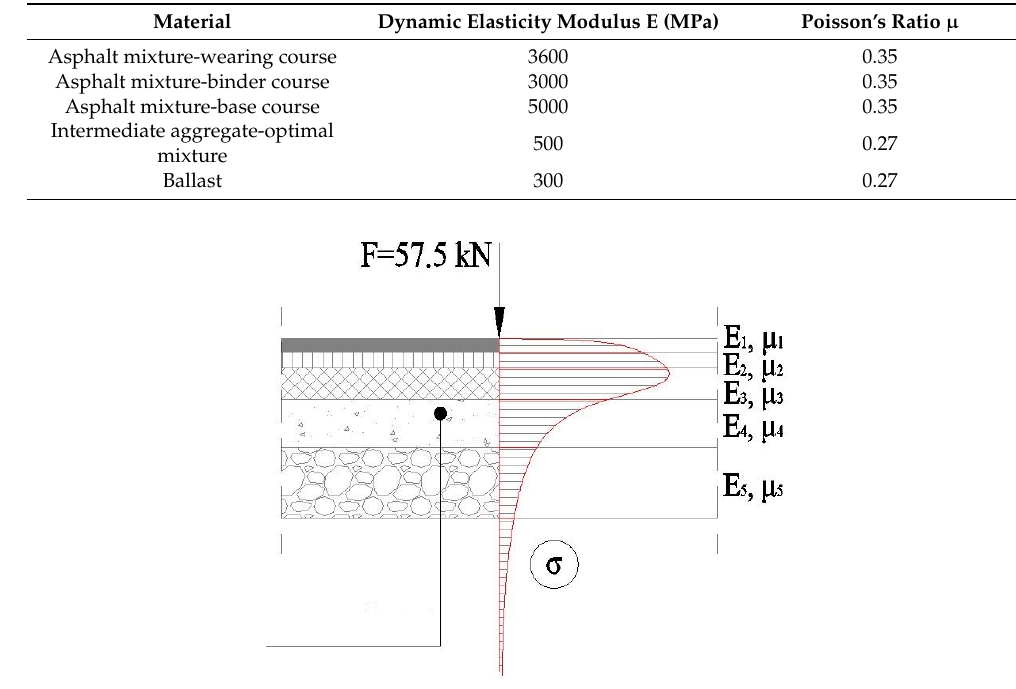
Figure 5. Distribution of stresses on the thickness of the road structure.